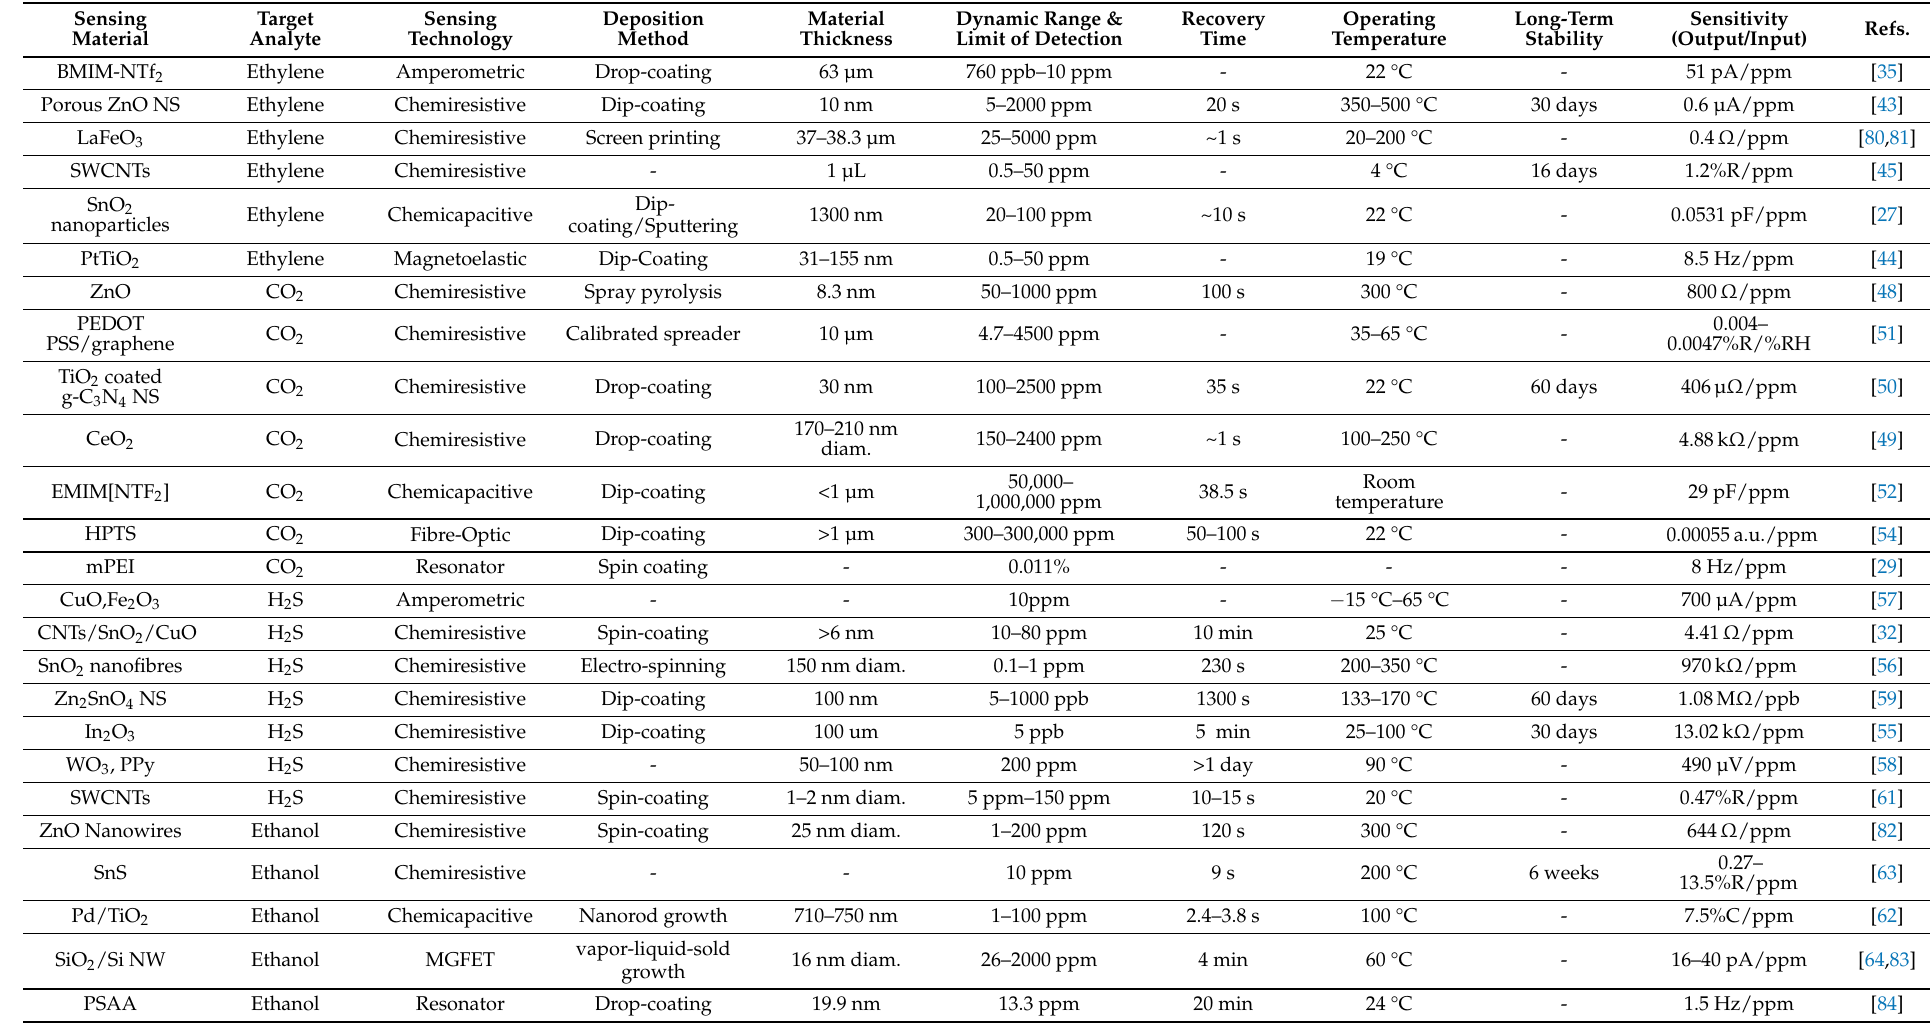
Table 2. Material deposition methods, sensing technologies, sensor performance parameters and operating temperatures with various sensing materials and target analytes in gas